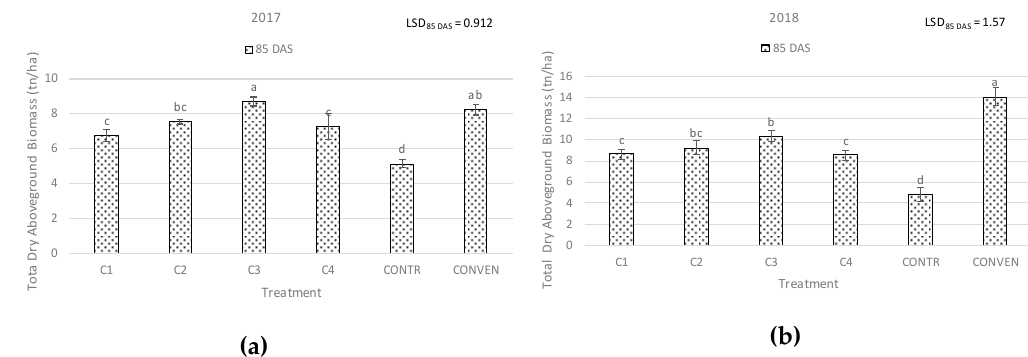
Figure 3. Height of rice plants (means ± se) grown in differently fertilized soil at 42, 60, and 80 days after the sowing (DAS) of the experiment during 2017 ( a ) and 2018 ( b ). Treatments contain compost application of (i) 80 kg ha − 1 N in split application (C1), (ii) 160 kg ha − 1 N in split application (C2), (iii) 320 kg ha − 1 N in split application (C3), (iv) 160 kg ha − 1 N in single application (C4), (v) an untreated control (CONTR), and (vi) 160 kg ha − 1 nitrogen chemical fertilizer (CONVEN). Means were compared by the Bonferroni adjusted LSD value at p < 0.05. Different letters characterize significant differences between treatments for each DAS. Full description of the treatments examined is given in Table 3.